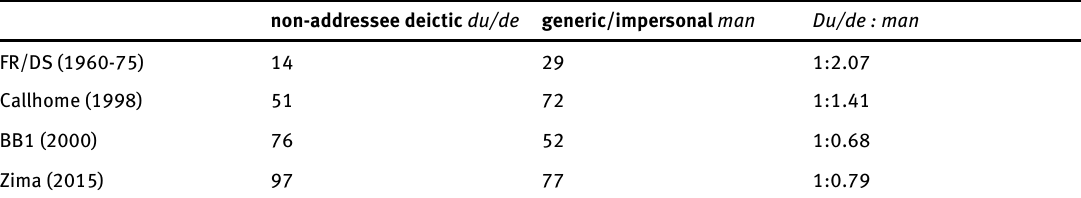
Table 1: Frequency of non-addressee deictic du/de and generic/impersonal man in speakers who are in a du -relationships; only in conditional clauses; data from 1960 to